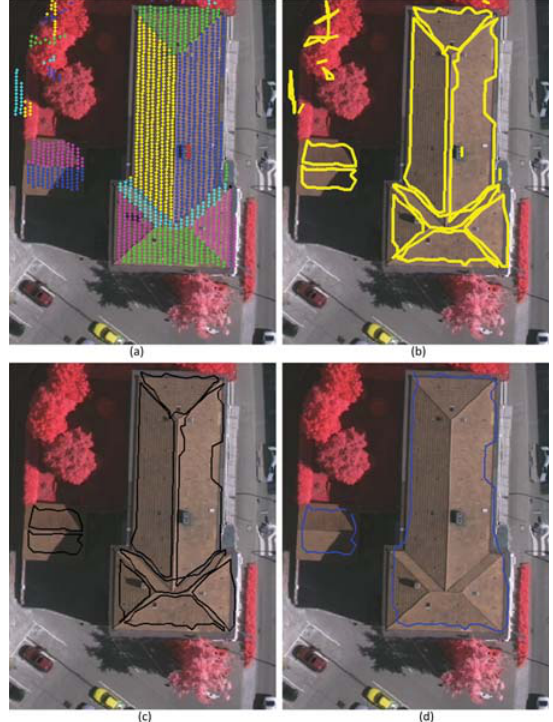
Figure 4: Removal of false planes: (a) all extracted planes, (b) all plane boundaries, (c) final plane boundaries, and (d) building boundaries.